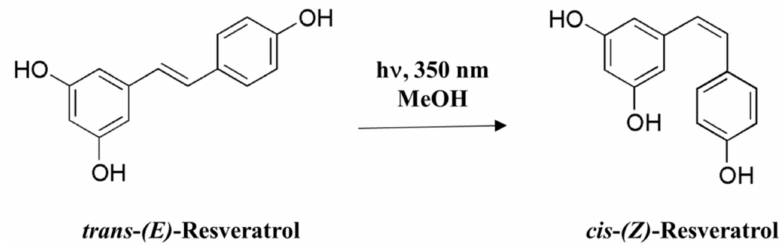
Figure 1. Resveratrol